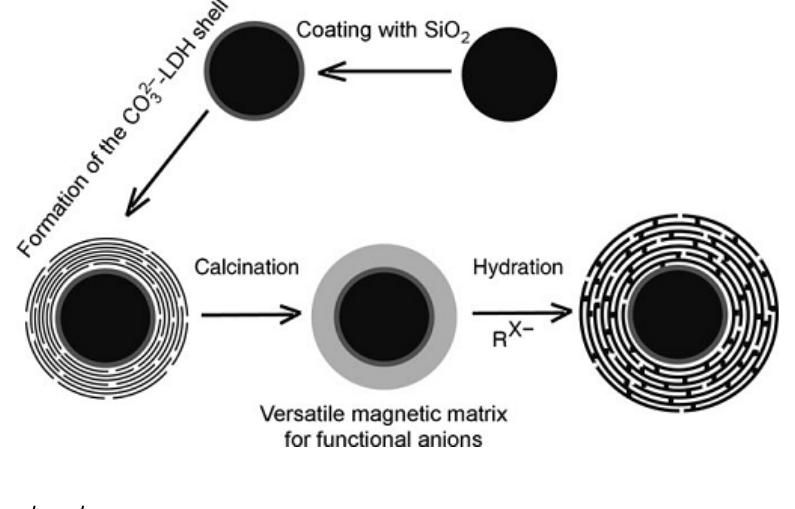
Figure 3. Synthesis of the magnetic Fe with permission from [18], © Wiley-VCH,